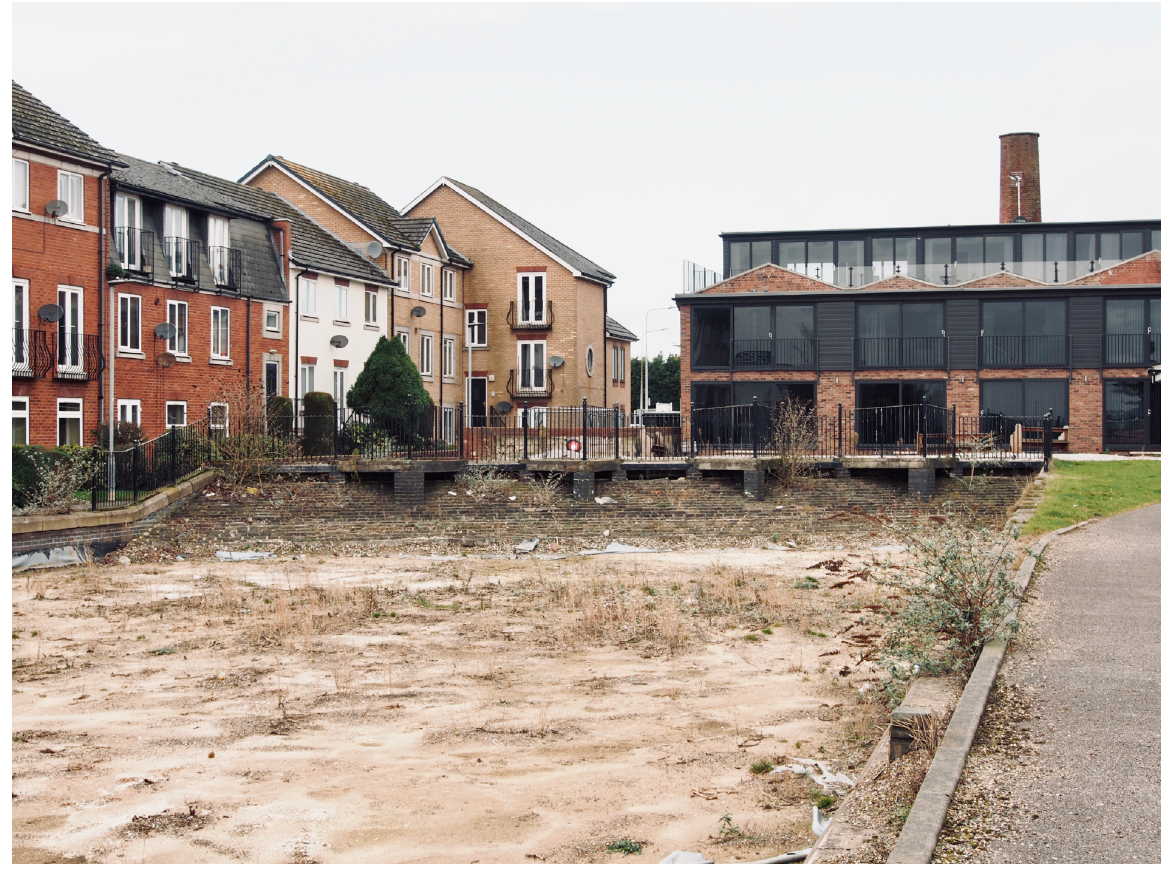
Silted locally listed slipway, original photo by author,